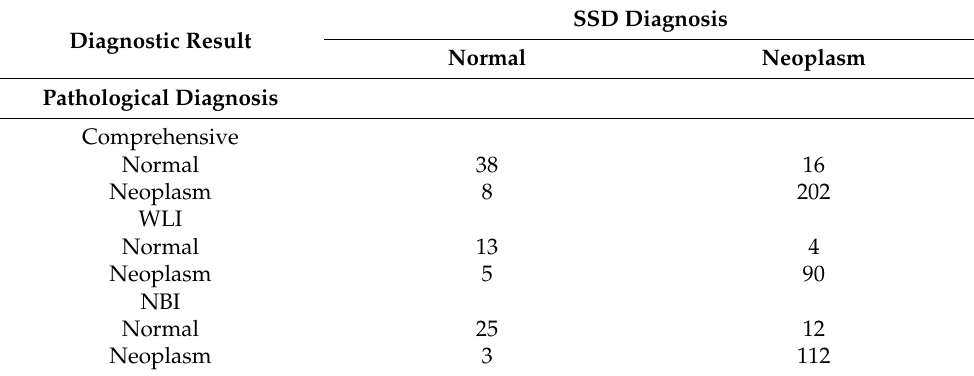
Table 1. Detailed results of 264 esophageal images diagnosed by our single-shot multibox detec- tor (SSD).